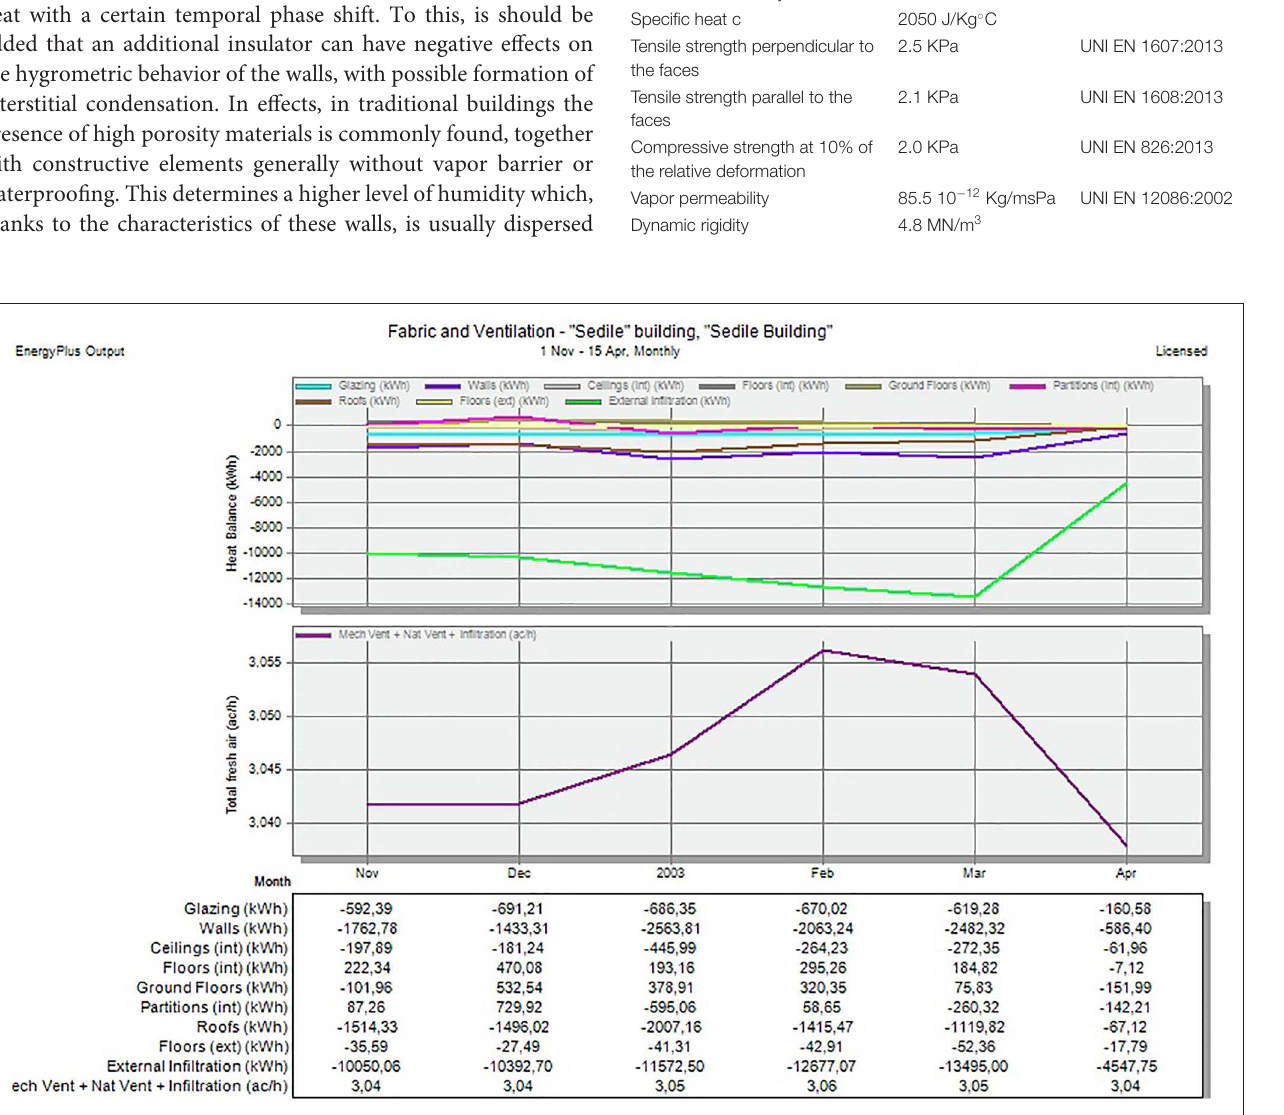
FIGURE 9 | Fabric and ventilation (source DesignBuilder